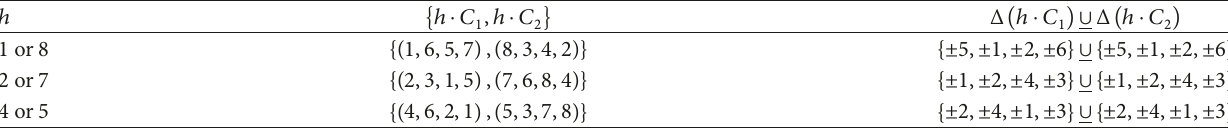
Table 3: A collection of distinct starters of simple cyclic (9, 4,2) - 𝑁𝑅𝐶𝑆